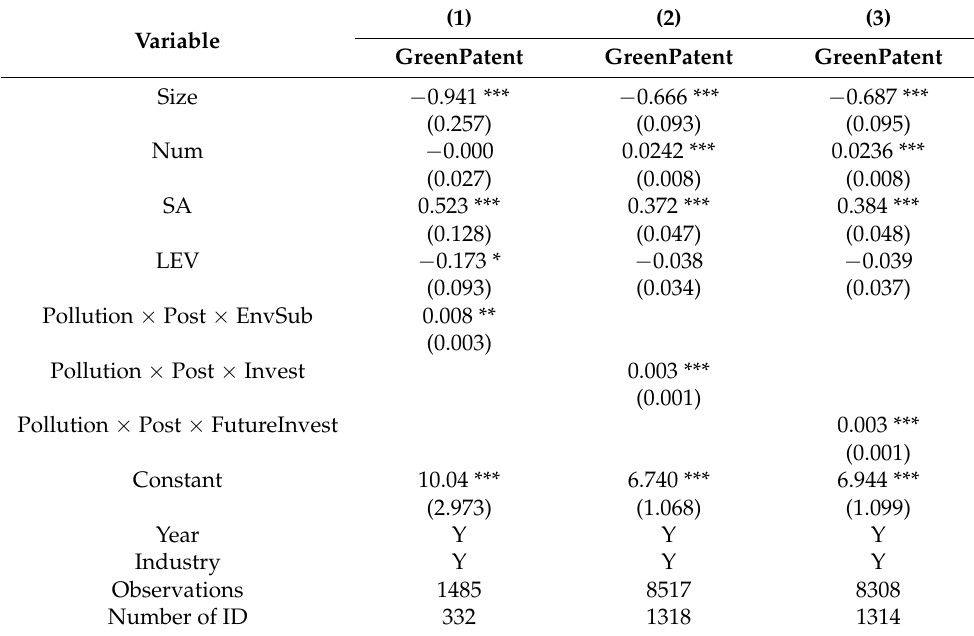
Table 11. Environmental regulation and corporate green innovation: mechanisms